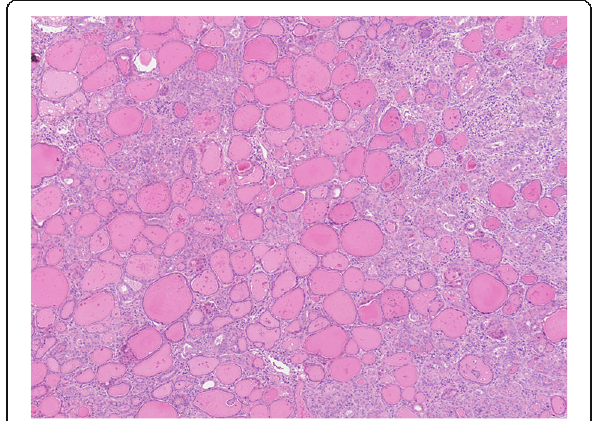
Fig. 5 Thyroid-like follicular renal cell carcinoma. The tumor consists of follicles with simple cuboidal epithelial cell lining. The follicular lumens contain eosinophilic proteinaceous fluid